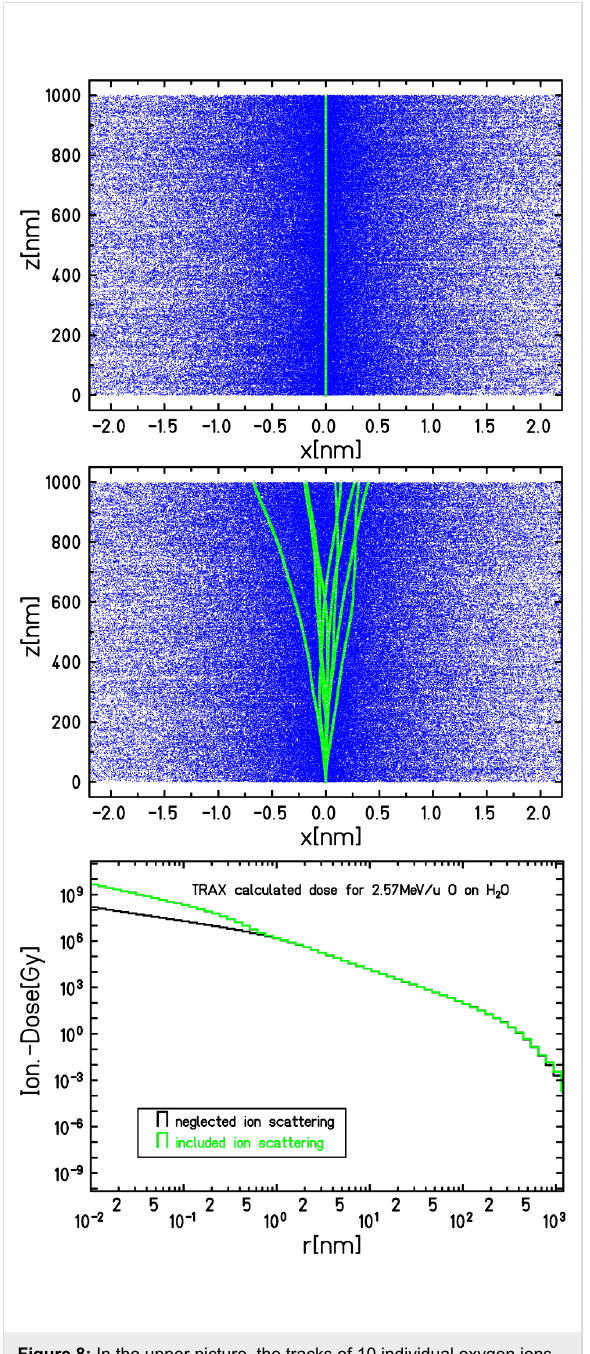
Figure 8: In the upper picture, the tracks of 10 individual oxygen ions with a primary energy of 2.57 MeV/u, incident on water, are shown while the elastic scattering of ions is neglected. They all travel straight through the medium. The blue spots indicate the interaction positions of the secondary electrons. In the central picture the same plot is shown including the elastic scattering of ions. The angular deflection over a travelling length of 1 μ m can be seen. On the nanometer scale, the shift of ionization and excitation events of the primary ions is noticeable. The resulting radial dose with and without elastic ion scat- tering is shown in the lower picture. It can be seen that the radial dose differs in the area that is equal to the radius of the elastic scattering of ions. The deflection of the primary ions leads to a natural "diffusion" of the radial dose.